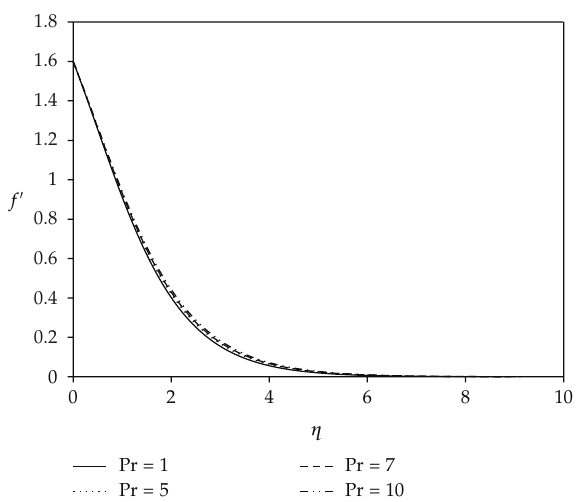
Figure 12: Velocity profile for di ff erent values of Pr for Du (cid:8) 0 . 03, Sr (cid:8) 2, θ r (cid:8) 5, Le (cid:8) 0 . 1, N (cid:8) 1, and Sc (cid:8) 0 . 1.